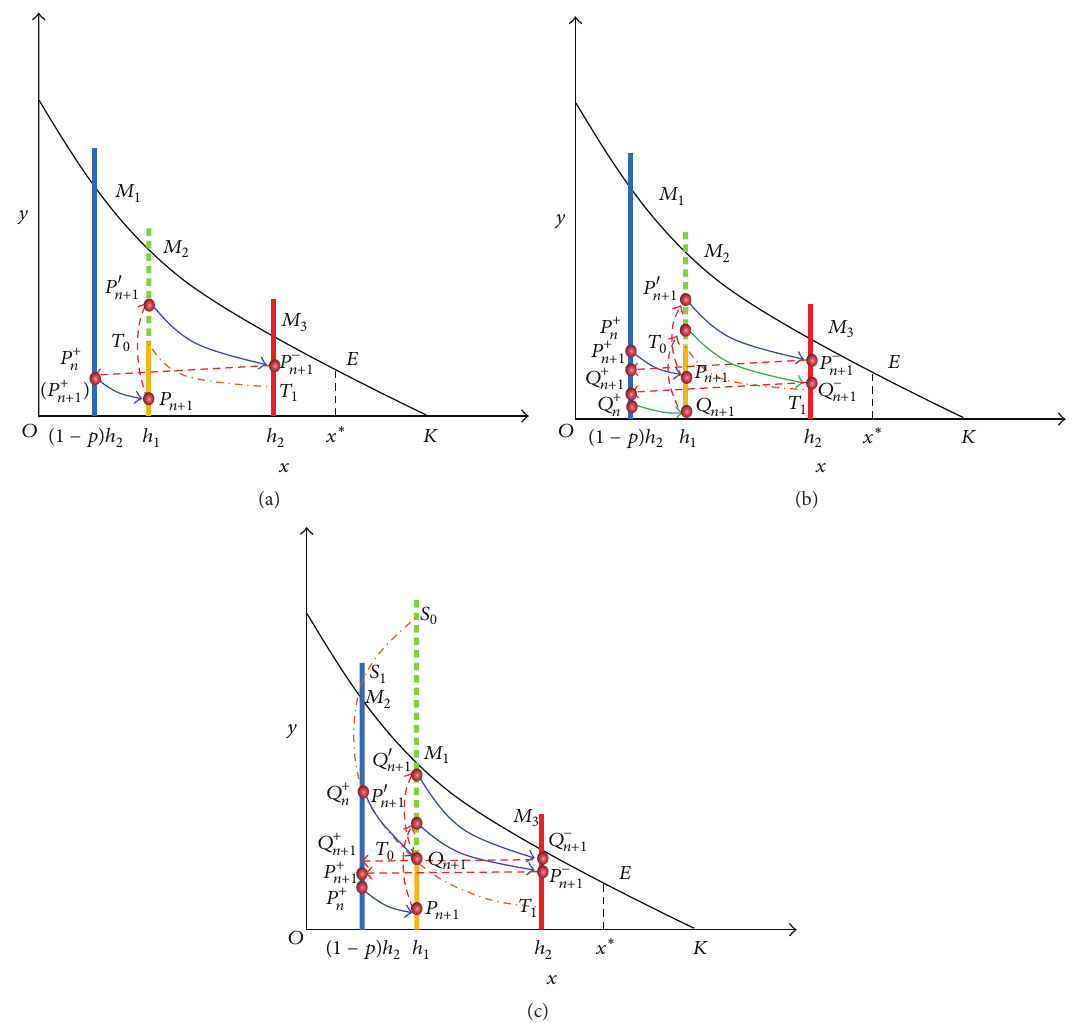
Figure 3: The trajectory of system (1) when (1 − 𝑝)ℎ 2 is less than ℎ 1 . (a) 𝑃 + 𝑛+1 overlaps with 𝑃 + 𝑛 ; (b) 𝑃 + 𝑛+1 is under 𝑃 + 𝑛 ; (c) 𝑃 + 𝑛+1 is above 𝑃 + 𝑛 .